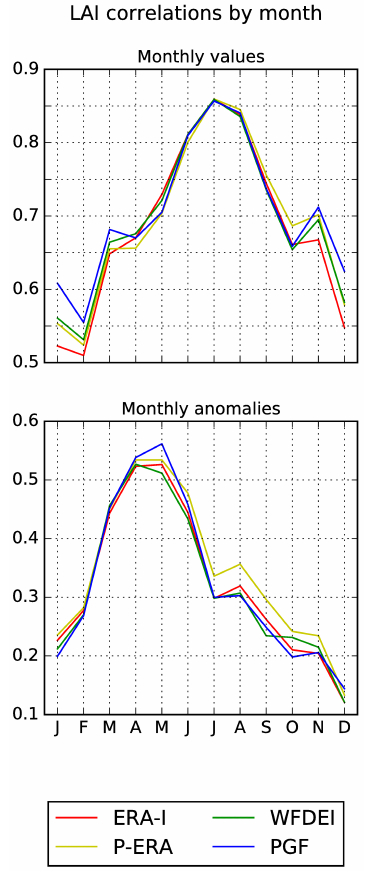
Figure 6. Annual cycles of correlation between modelled and re- motely sensed GIMMS LAI for monthly averages and anomalies. Coefficients are computed separately for each calendar